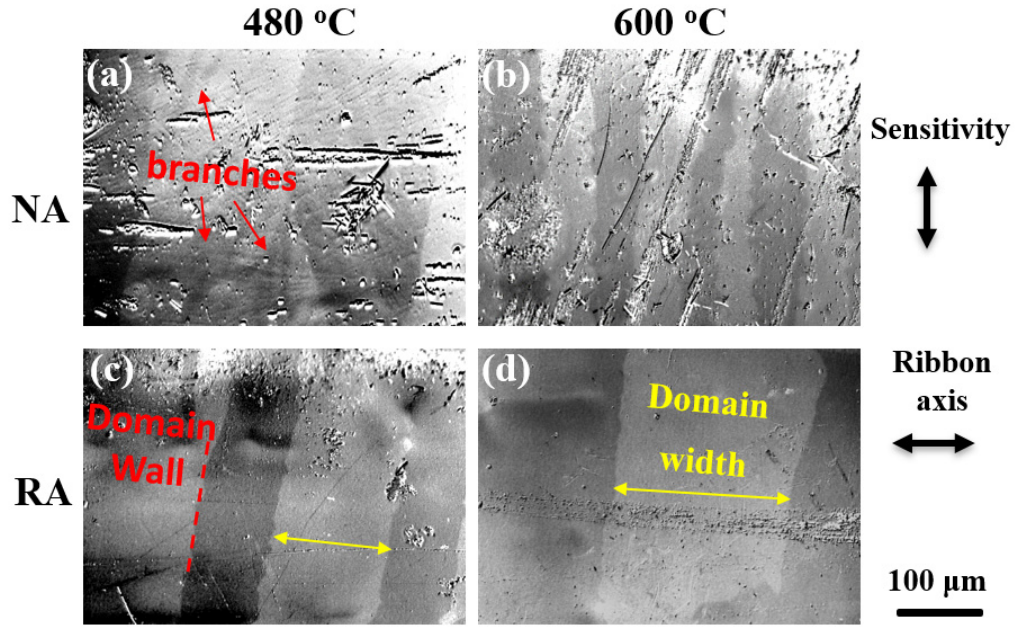
Figure 6. Magnetic domain structure of Mn2 annealed at 480 and 600 °C via ( a , b ) NA and ( c , d ) RA, respectively.